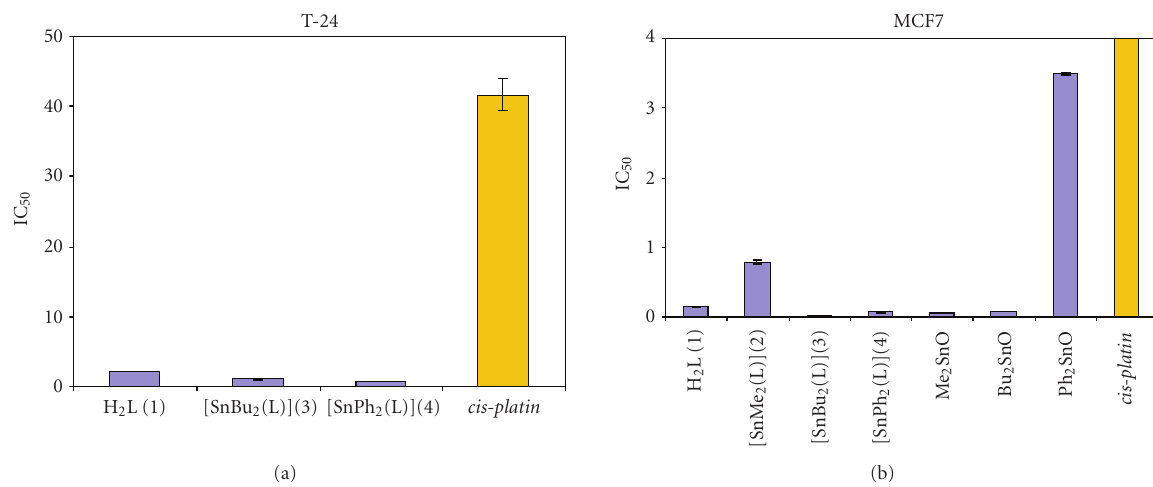
Figure 4: The antiproliferative activity in vitro expressed as IC 50 ± SD ( μ M) against (a) T-24 and (b) MCF-7 cancer cell